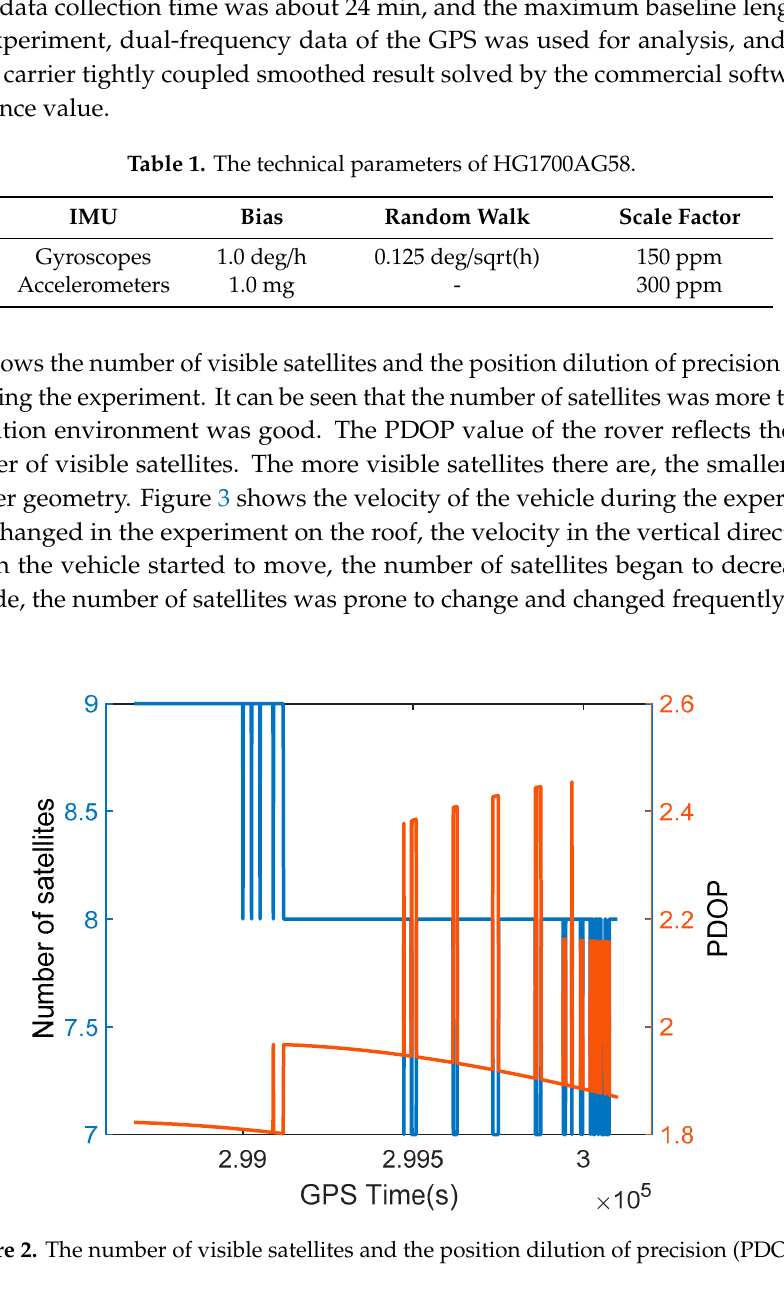
Figure 2. The number of visible satellites and the position dilution of precision (PDOP).